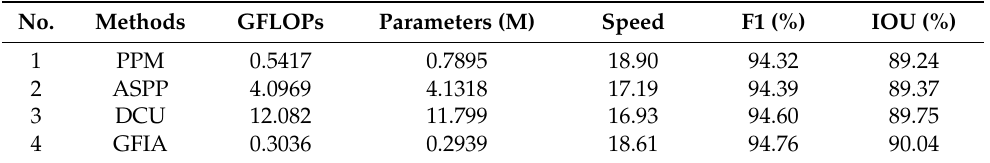
Table 6. Evaluation results of different global feature information awareness schemes on the WHU Building Dataset. Note: GFLOPs and parameters are computed from a tensor with a size of 1 × 512 × 32 × 32. The speed is tested with a batch size of 2, full precision (fp32), input resolu- tion of 3 × 256 × 256, and measured in examples/second.